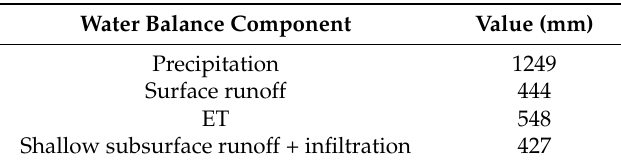
Table 8. Average annual water balance components of the base model for the entire watershed, from 2009–2011. Note that precipitation is lower than the sum of the other water balance components because of the structure of VELMA’s hydrological model output, which couples shallow subsurface runoff with infiltration.